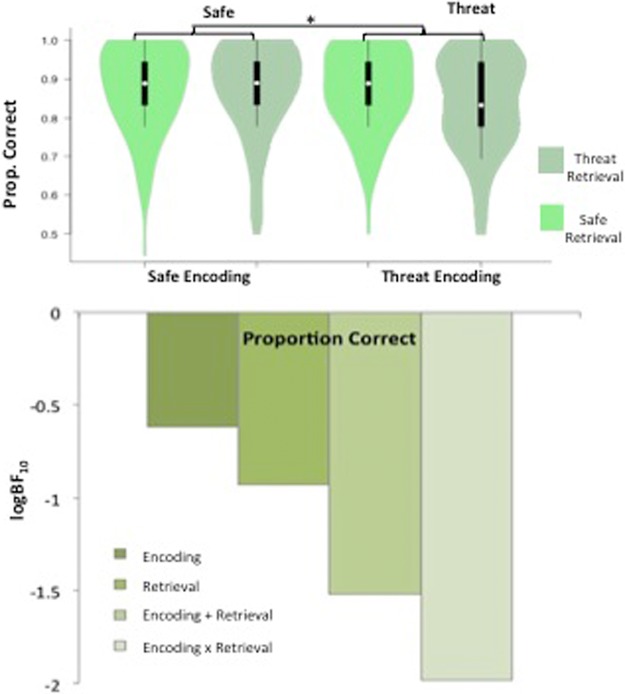
Verbal recognition task results. Violin plots displaying proportion correct for each condition, and bar charts representing the Bayesian model evidence for proportion correct for each condition.